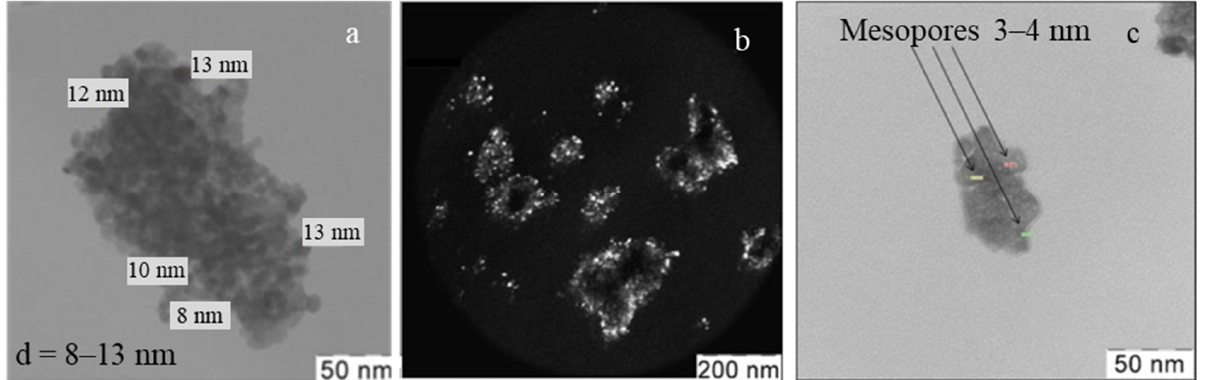
Figure 5. TEM data for the nano-zirconia synthesized: light-field ( a , c ) and dark-field ( b ) images.